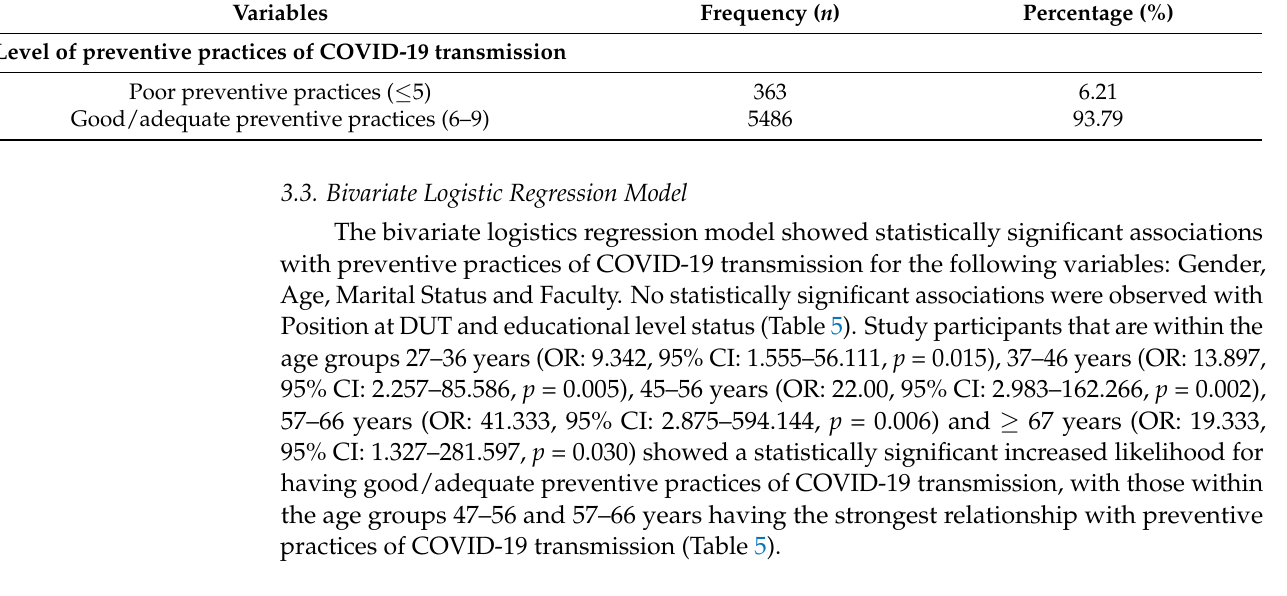
Table 5. Association between demographic characteristics and preventive practices of